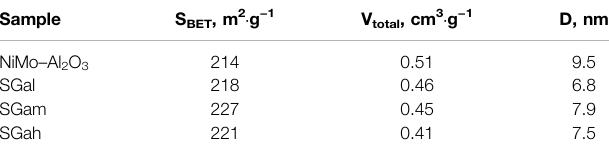
TABLE 1 | Pore structural properties of impregnated Ga-modi fi ed Ni – Mo/Al 2 O 3 .